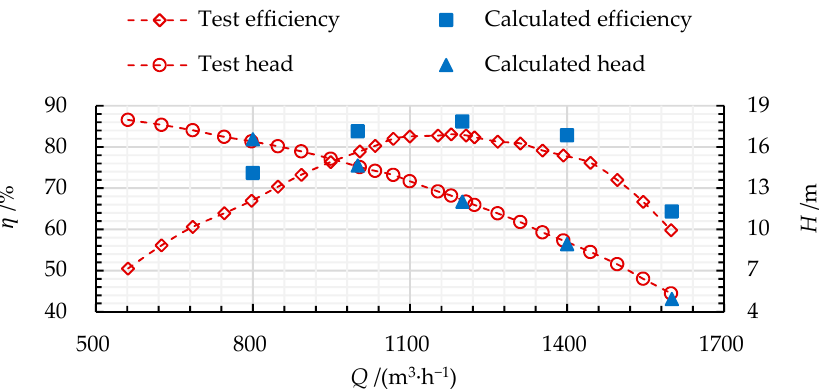
Figure 5. Comparison of test and calculated results of the mixed-flow pump with a volute.